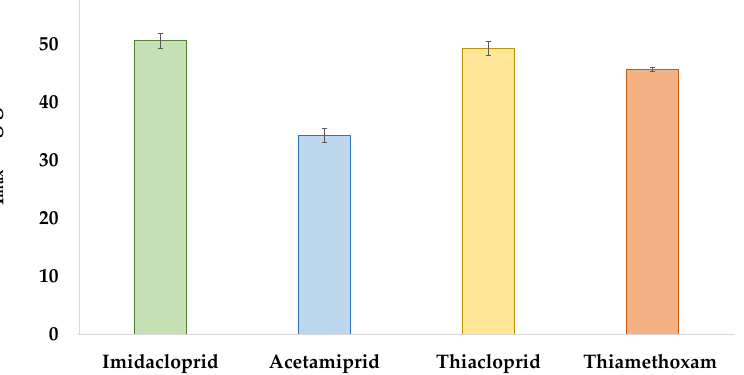
Figure 7. Maximum adsorption capacities were obtained from the continuous experiment in an SPE column using [Si][N 3888 ]Cl as adsorption material.